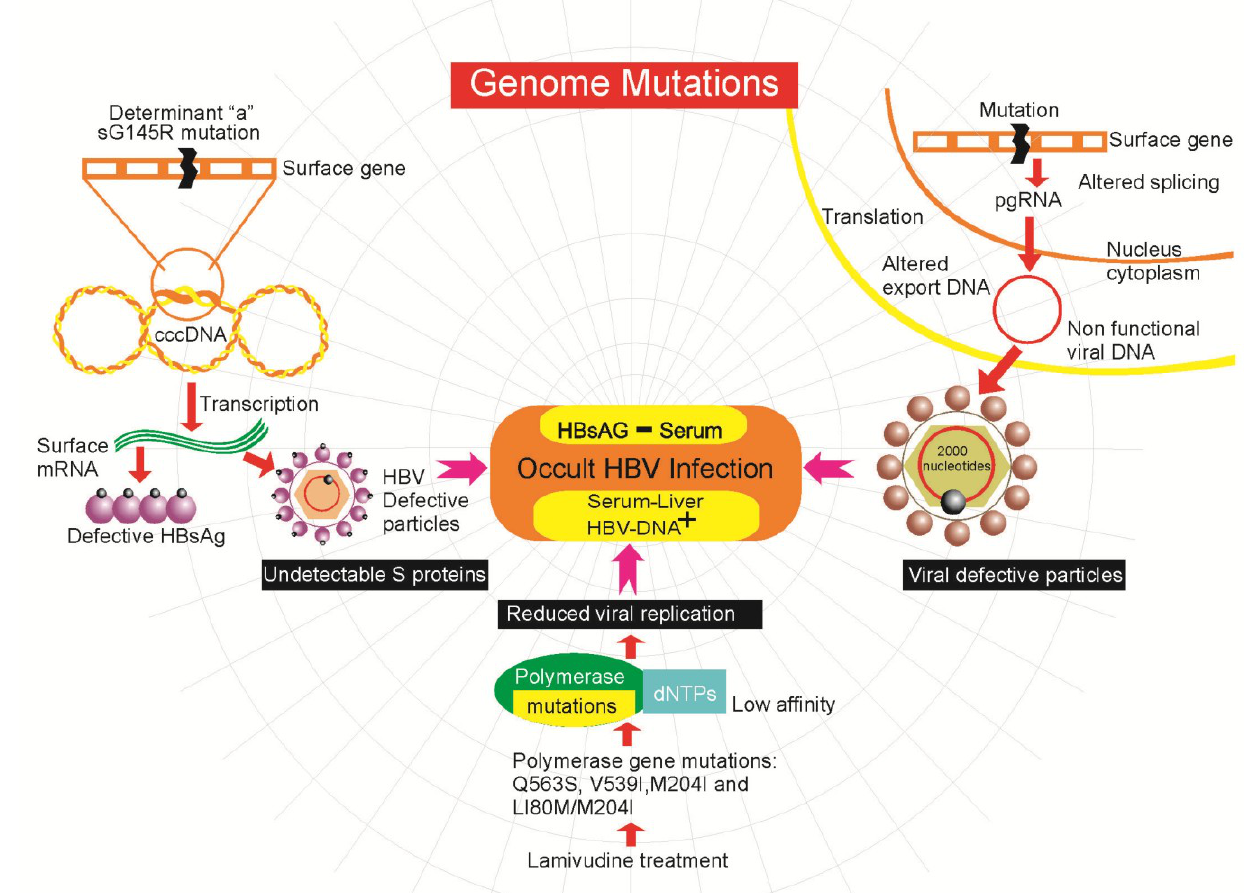
Figure 1. Genome mutations associated with the development of occult hepatitis B virus infection